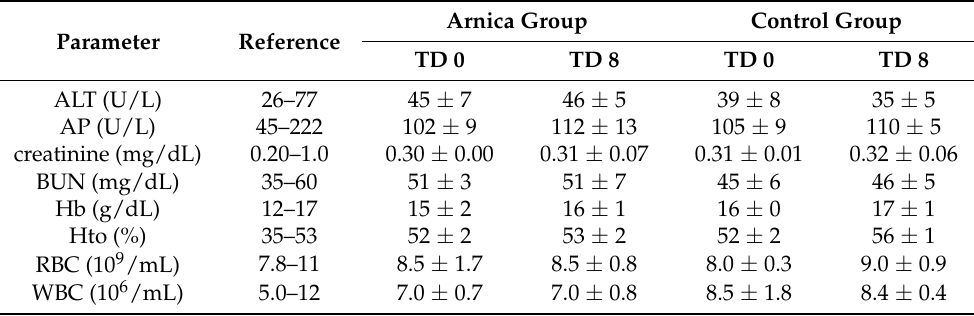
Table 5. Blood parameters in mice exposed to Arnica tincture ( n = 10) and the control group ( n = 6). Means ± standard deviations of each parameter determined before treatment (TD 0) and on day 8 after treatment (PTD 8). Reference values from